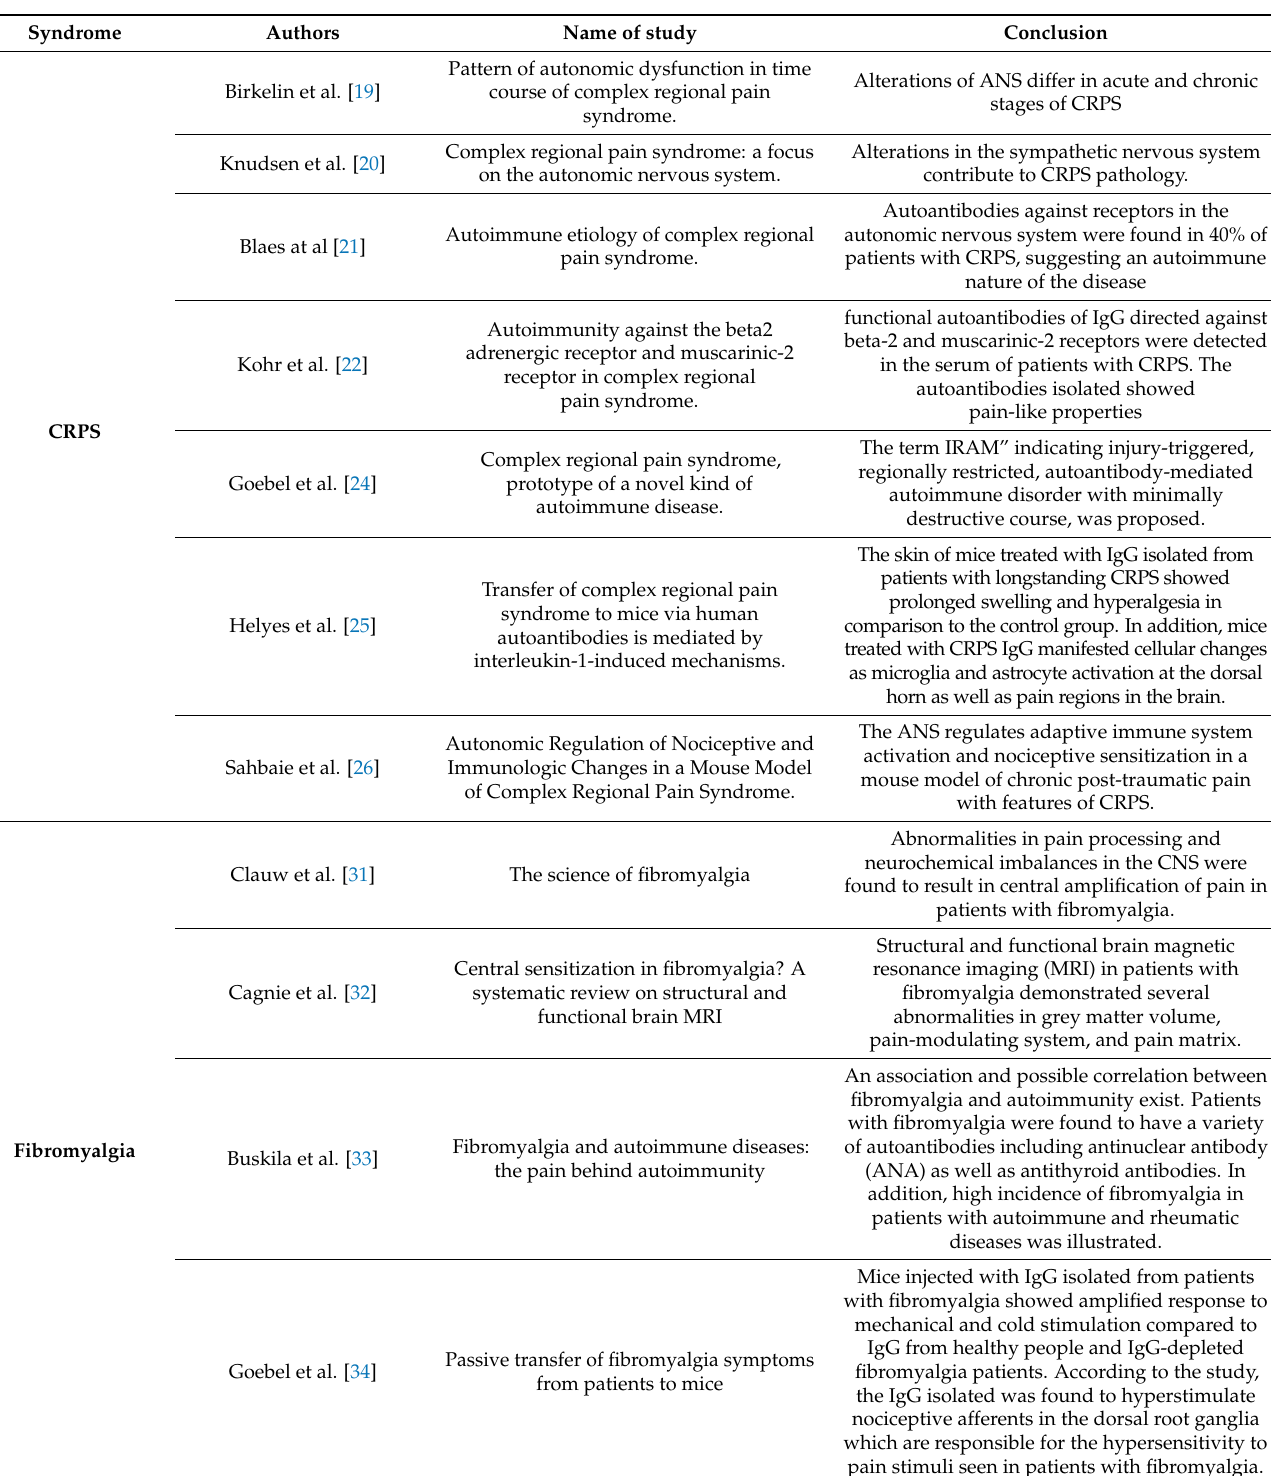
Table 1. Papers and studies addressing autoimmune mechanisms in the syndromes